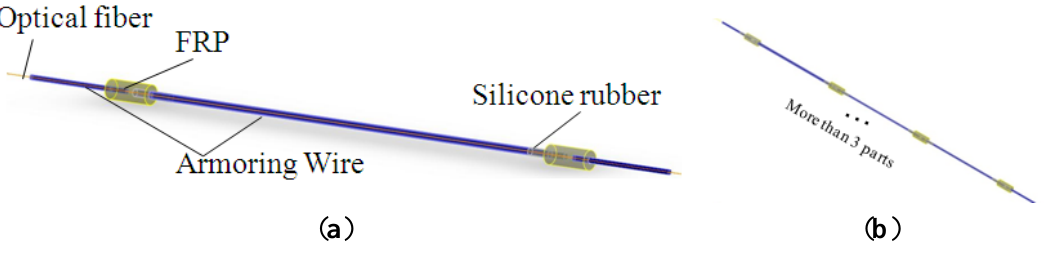
Figure 13. Sketch of a quasi-distributed OF sensor. ( a ) Structure of single sensing part; ( b ) Assembled quasi-distributed sensor.